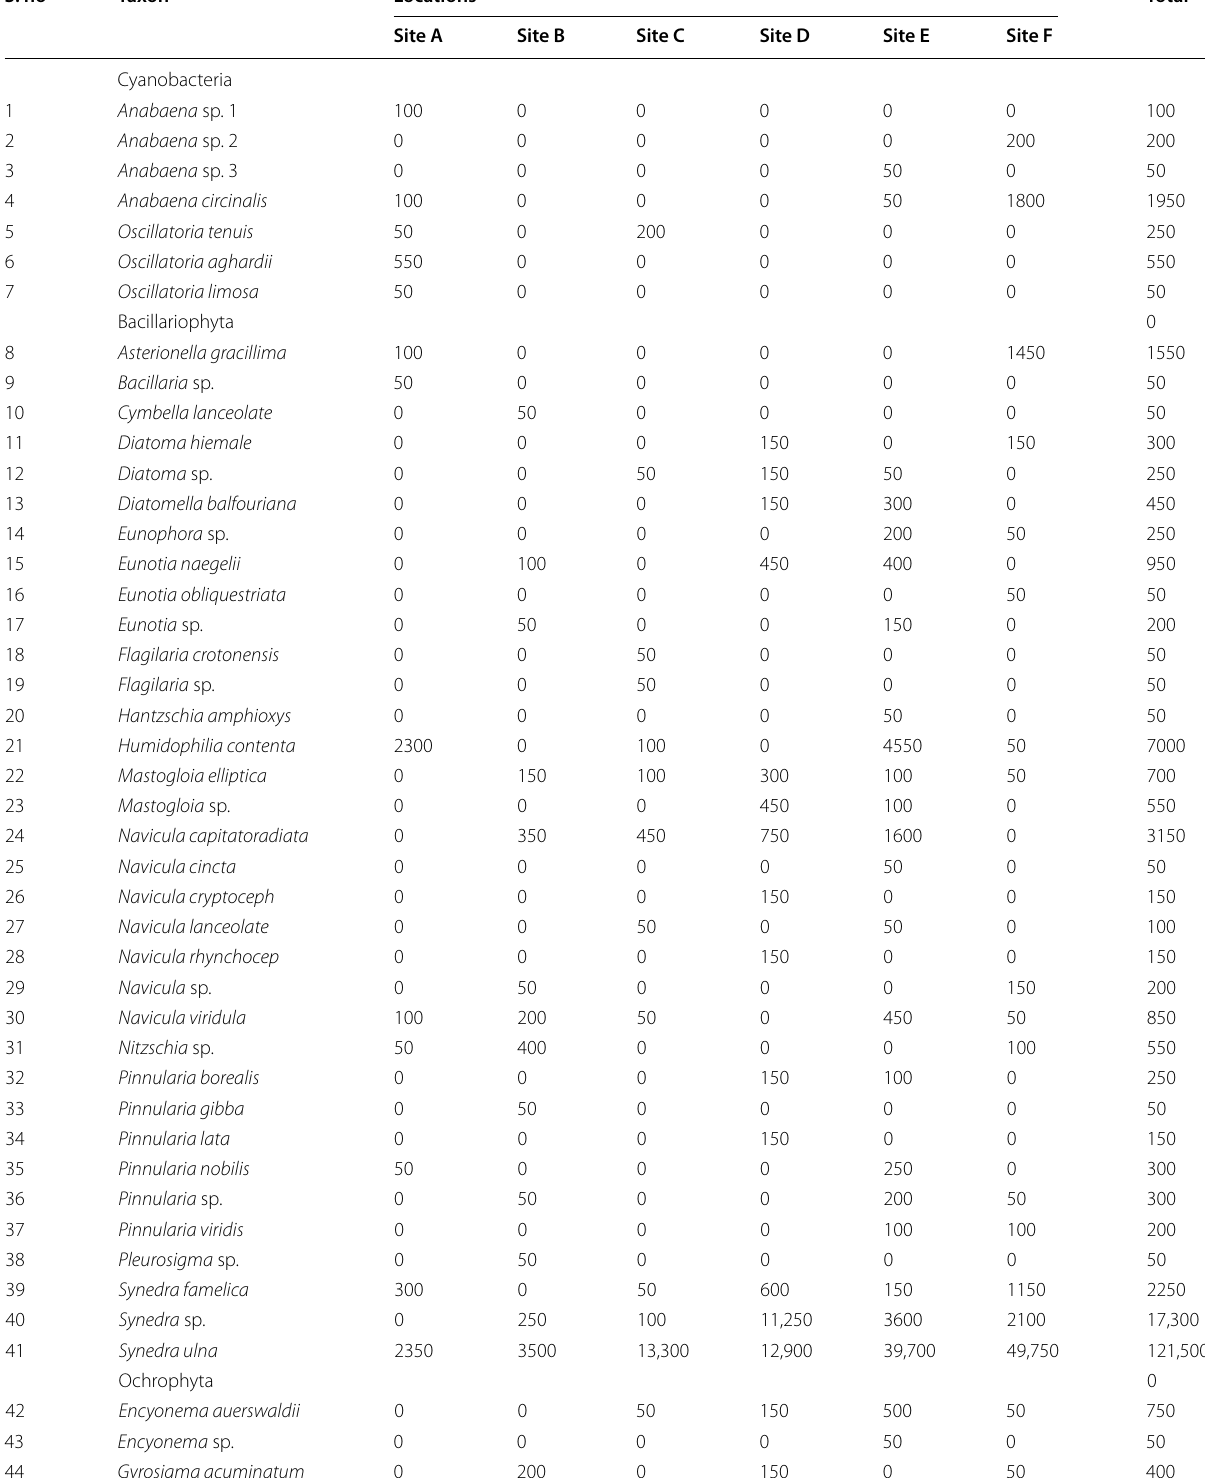
Table 3 Phytoplankton species occurrence and abundance (individuals/m 3 ) in the Opa Reservoir, Obafemi Awolowo University,